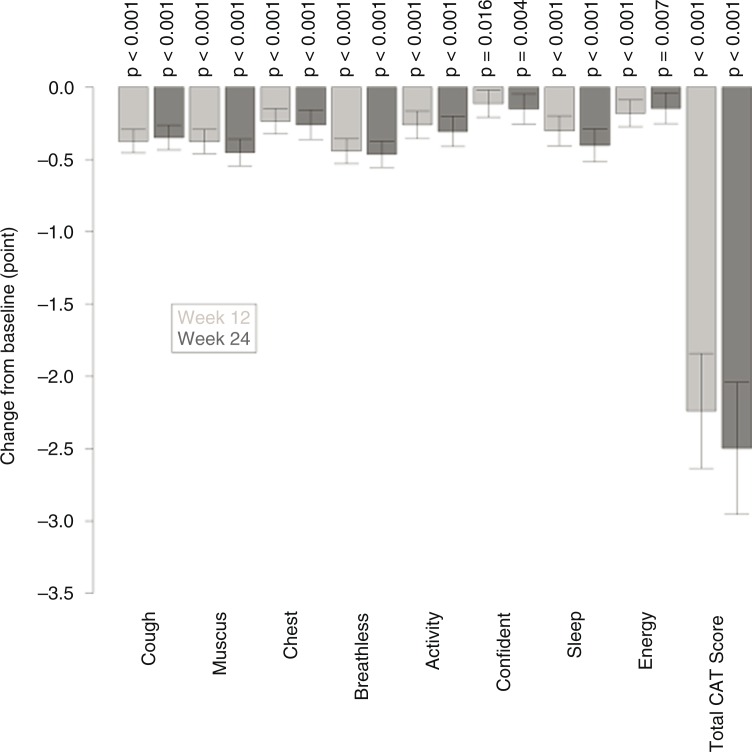
Change in individual CAT item scores and total CAT score from baseline to week 12 (light grey bars) and from baseline to week 24 (dark grey bars). Sample size: N=774 (week 12) and N = 679 (week 24). ‡p<0.01 for baseline versus follow-up (weeks 12 and 24); †p<0.05 for baseline versus follow-up (weeks 12 and 24).